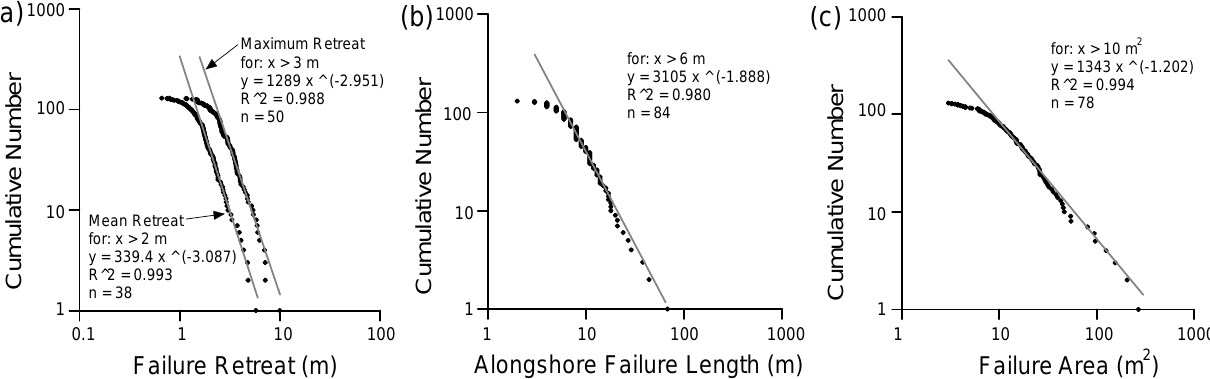
Fig. 8. Log of the cumulative number of failures versus log of (a) mean and maximum failure retreat, (b) alongshore length, and (c) area.